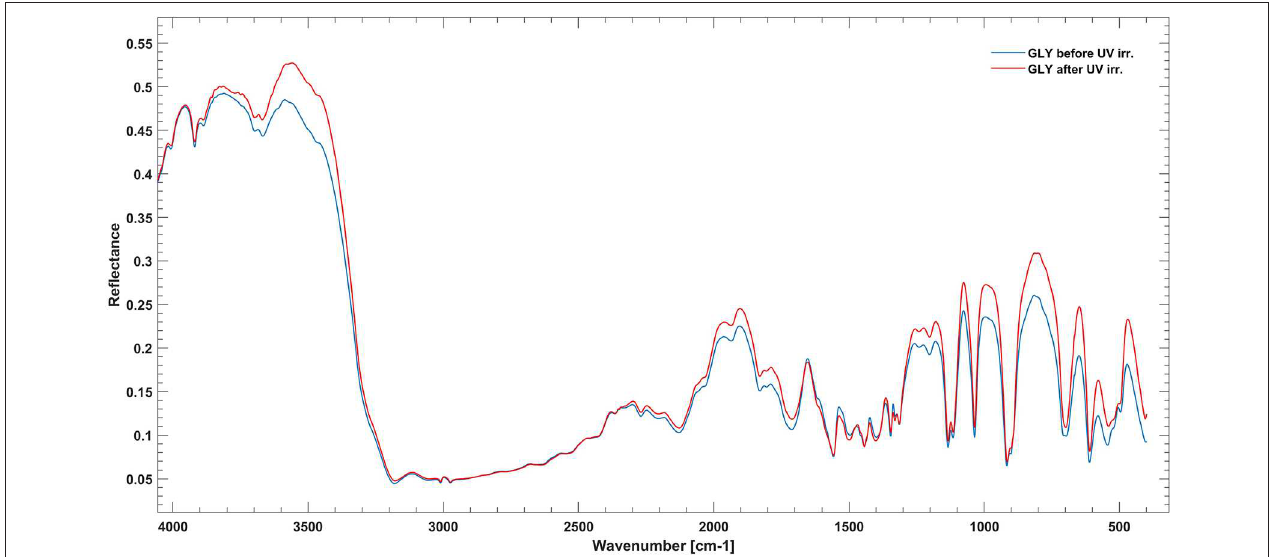
FIGURE 5 | Superimposition of infrared spectra of GLY adsorbed on pyrite in the range 2,000–500 cm − 1 during 7h of UV irradiation. Spectra were collected in situ at 1-h intervals to monitor the kinetics of degradation in real time.